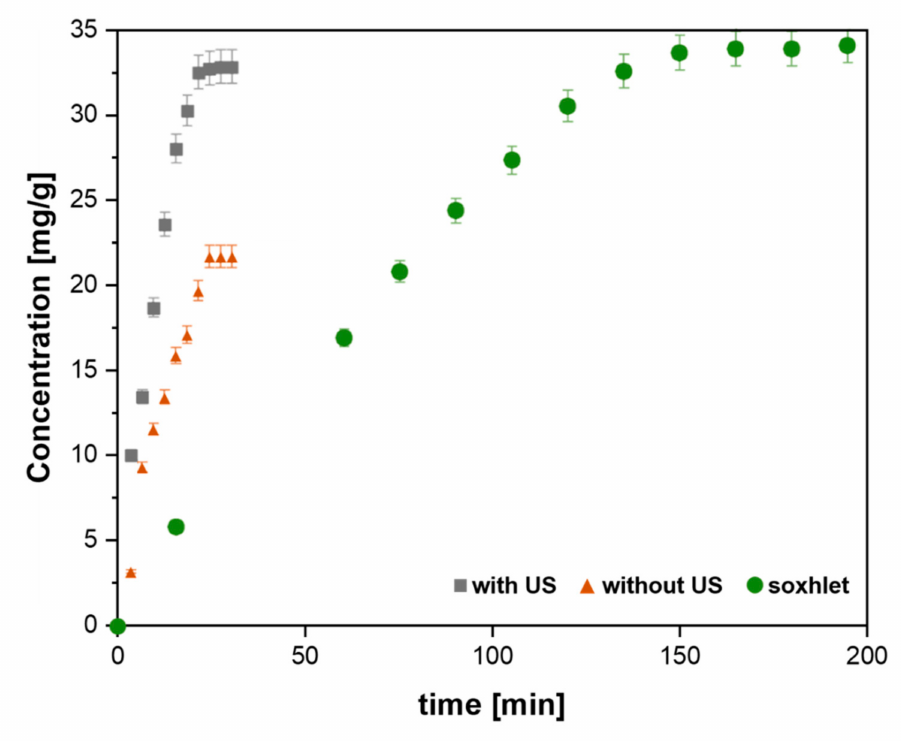
Figure 3. Comparison of ultrasonic-assisted extraction (UAE) with conventional extraction methods. Adapted with permission from Khandare et al. [69]. Copyright (2021) Elsevier